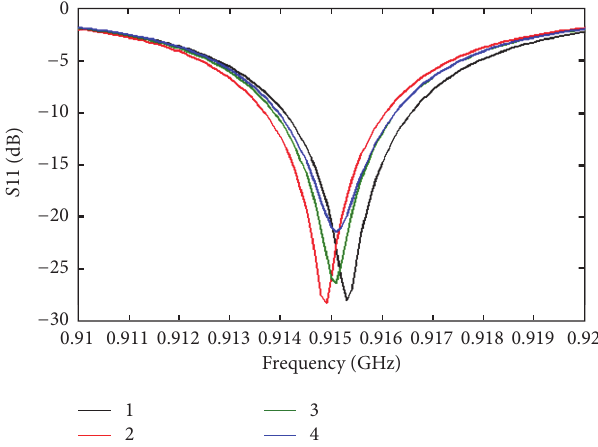
Figure 24: Return loss 𝑆11 of each 3D spherical antenna (Table